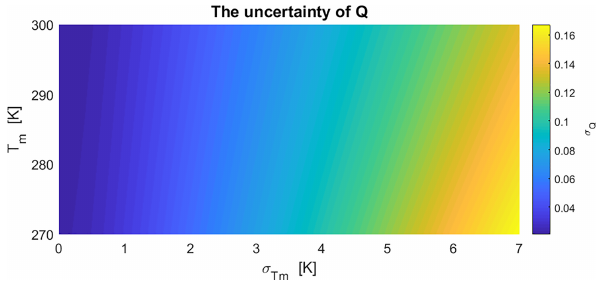
, σ T , P s and PWV. s m